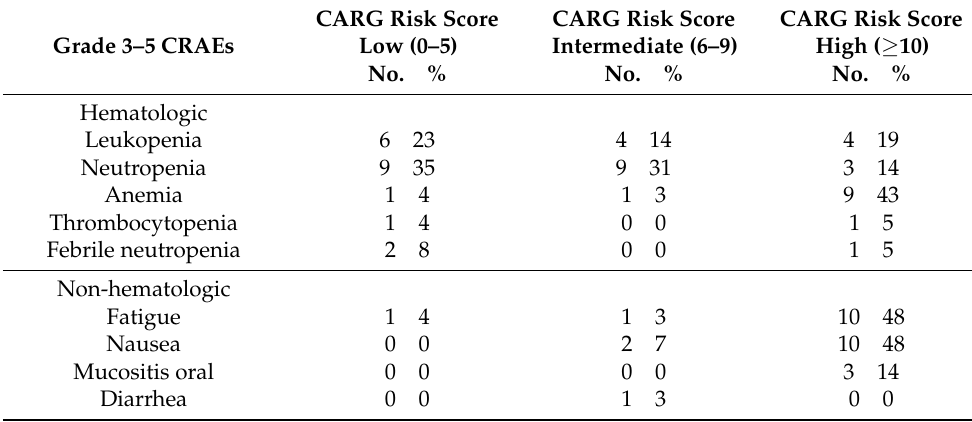
Table 2. Chemotherapy-related adverse events by CARG risk